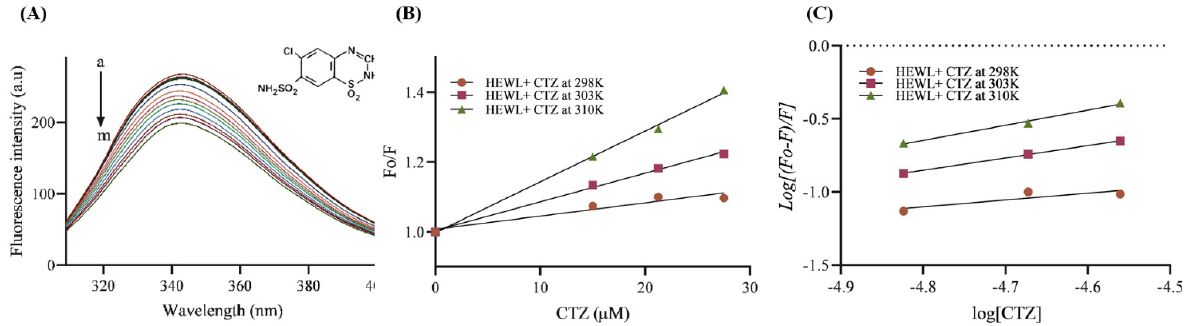
Figure 7. ( A ) Quenching spectra of the HEWL intrinsic fluorescence by increasing amounts of CTZ at 298K. The arrow indicates the increase of the CTZ concentration. C CTZ (a − m) = 0 − 27.5 µM and C HEWL = 5 µM. ( B ) Stern − Volmer plots of HEWL fluorescence quenching by CTZ at 298, 303, and 310K. ( C ) Plot of modified Stern − Volmer equation regarding the interaction between CTZ and HEWL at 298, 303, and 310K.